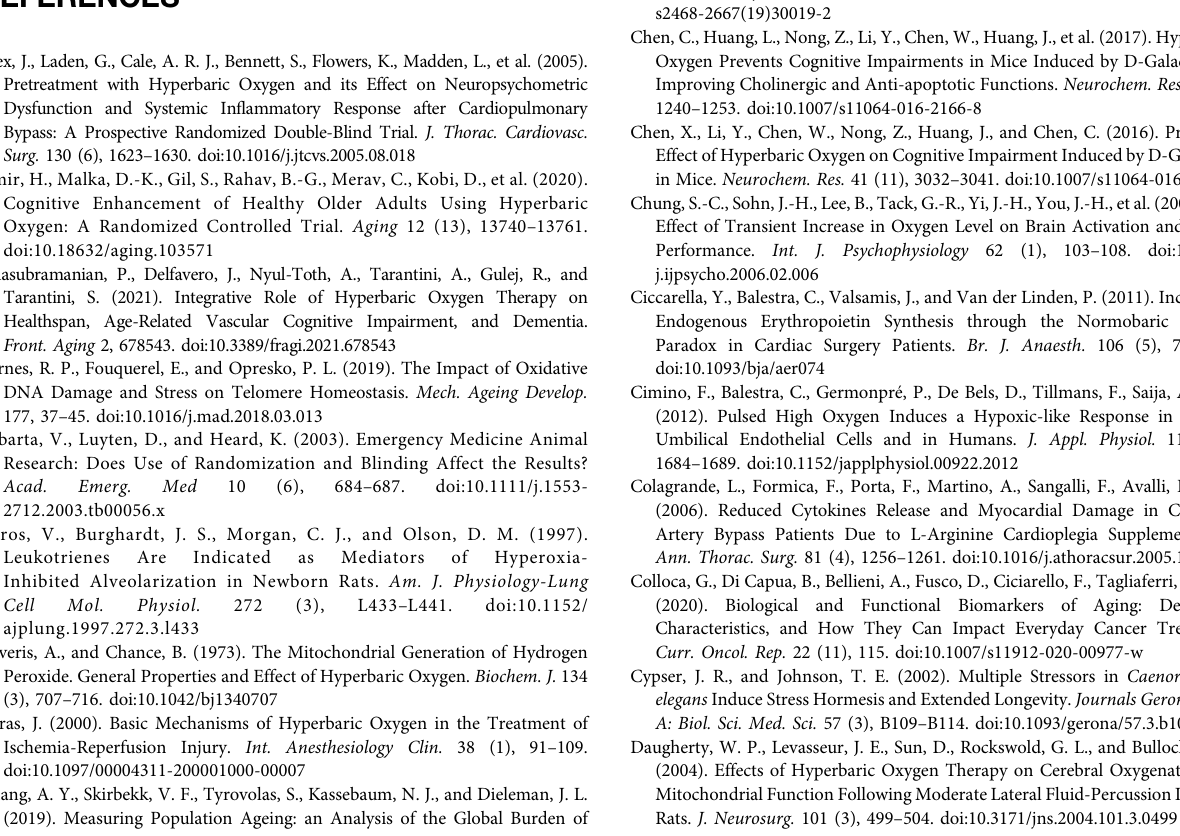
Supplementary Table S1 | The effect of hyperoxia on aging markers in human.